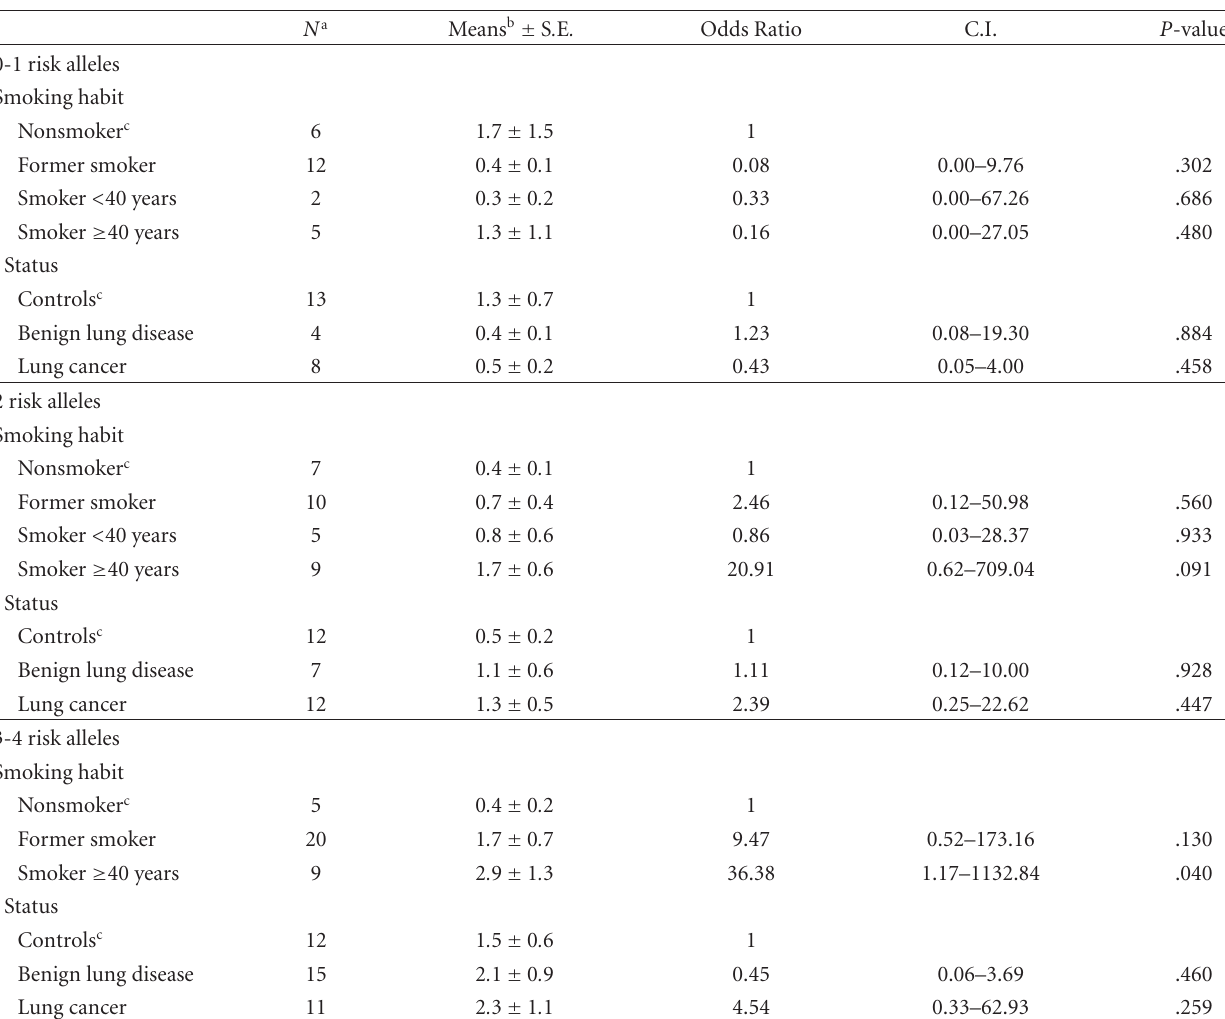
Table 2: Means of DNA adducts ± standard error (SE) case-control status considering the number of DNA repair risk alleles plus the parameter estimates of the multivariate regression